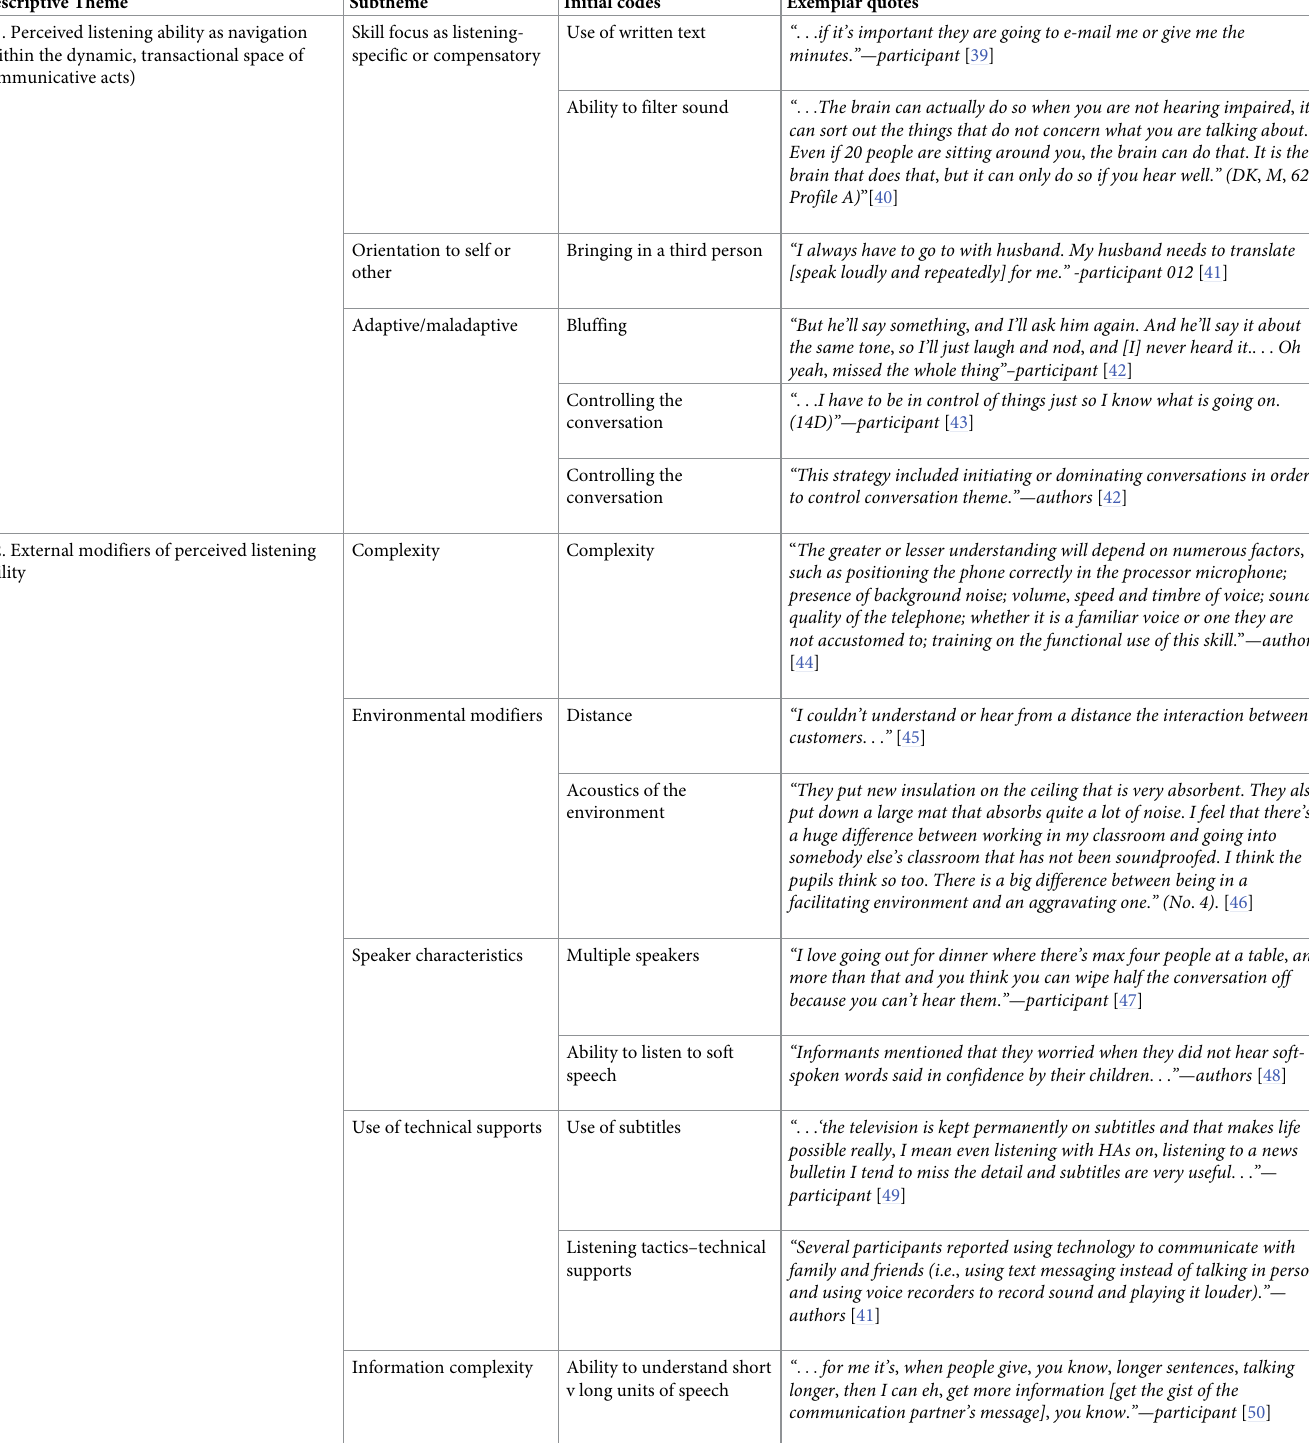
Table 3. Development of the descriptive and analytic themes showing examples of the initial codes comprising the descriptive themes with supporting exemplar quotes. Descriptive